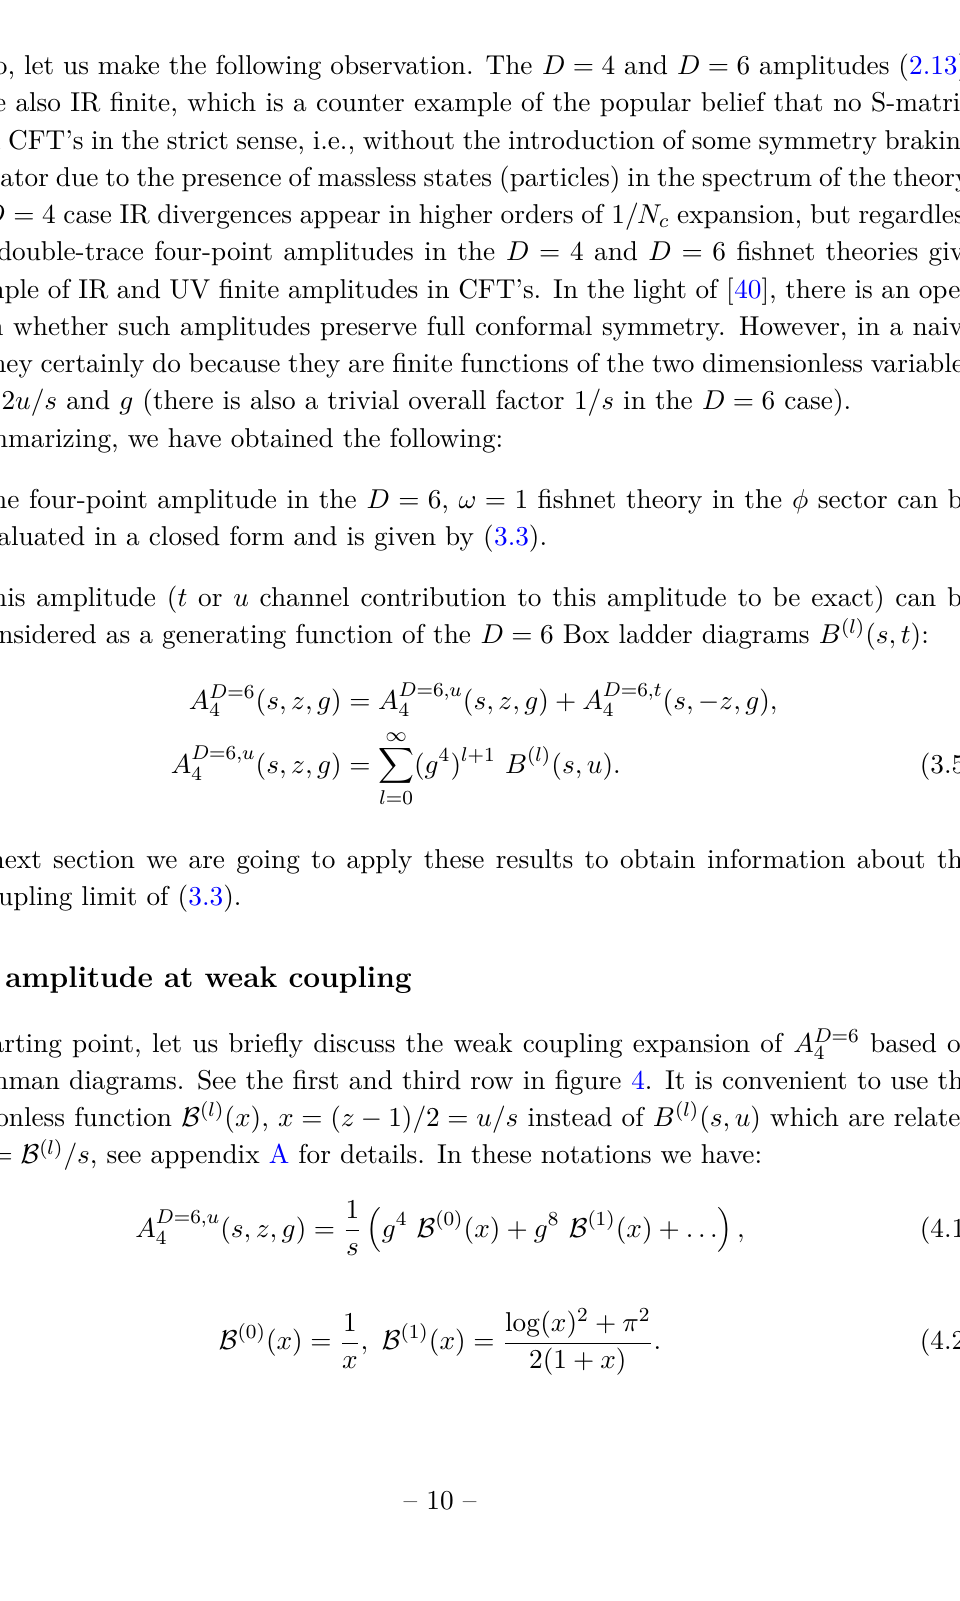
Figure 7 . Equivalent forms of the D = 6 on-shell Box ladder